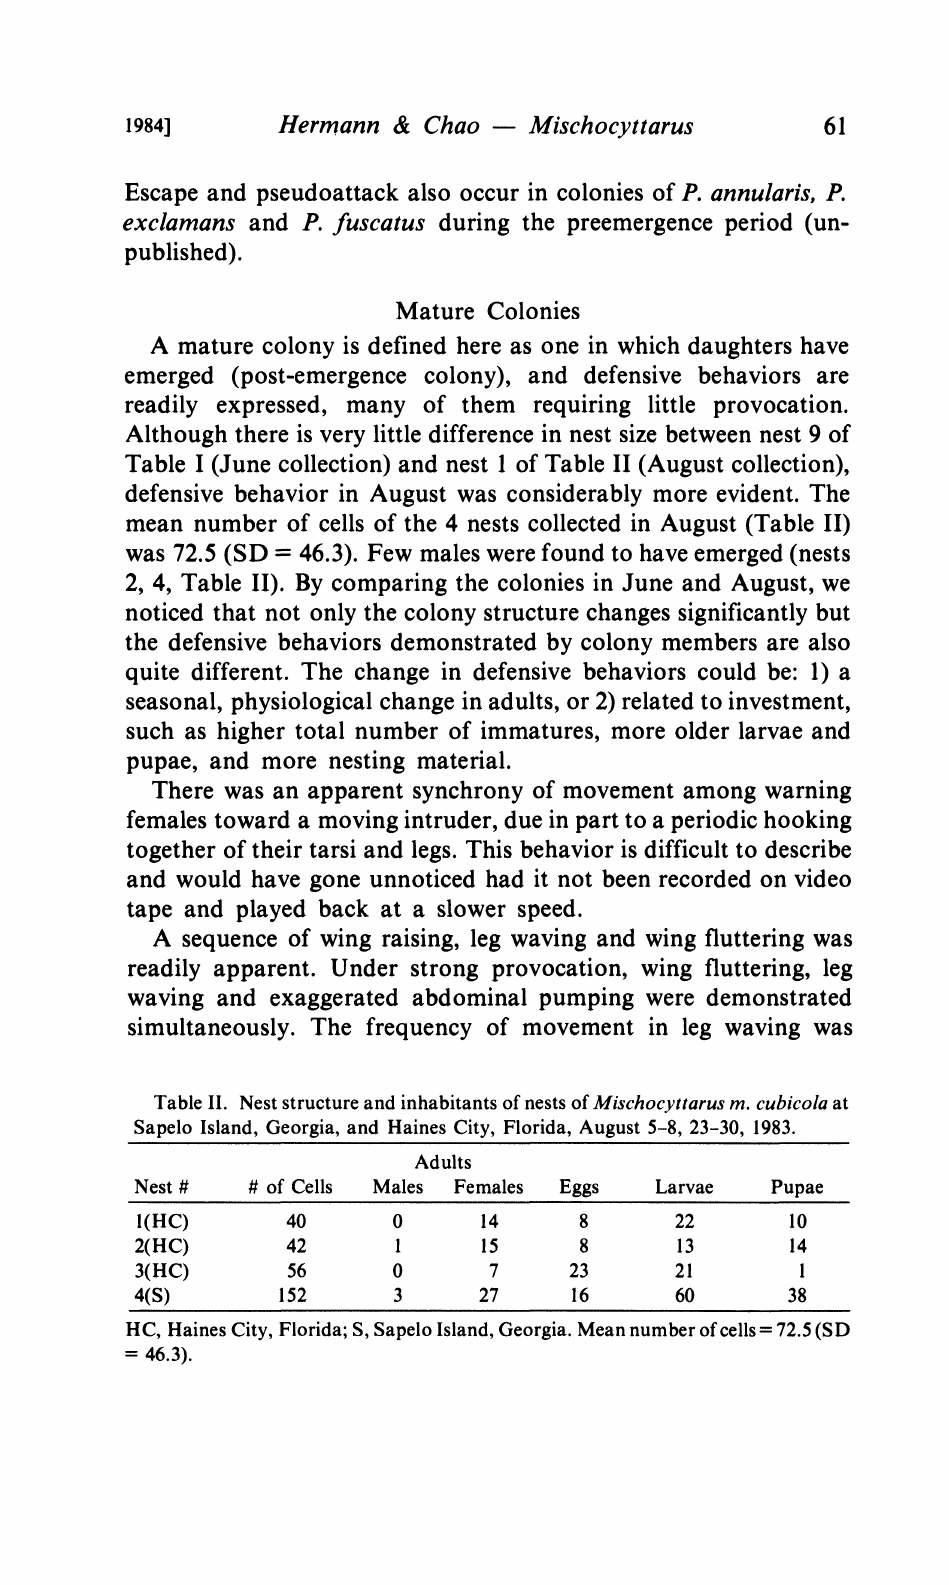
Table II. Nest structure and inhabitants of nests of Mischocyttarus m. cubicola at Sapelo Island, Georgia, and Haines City, Florida, August 5-8, 23-30, 1983. Adults Nest